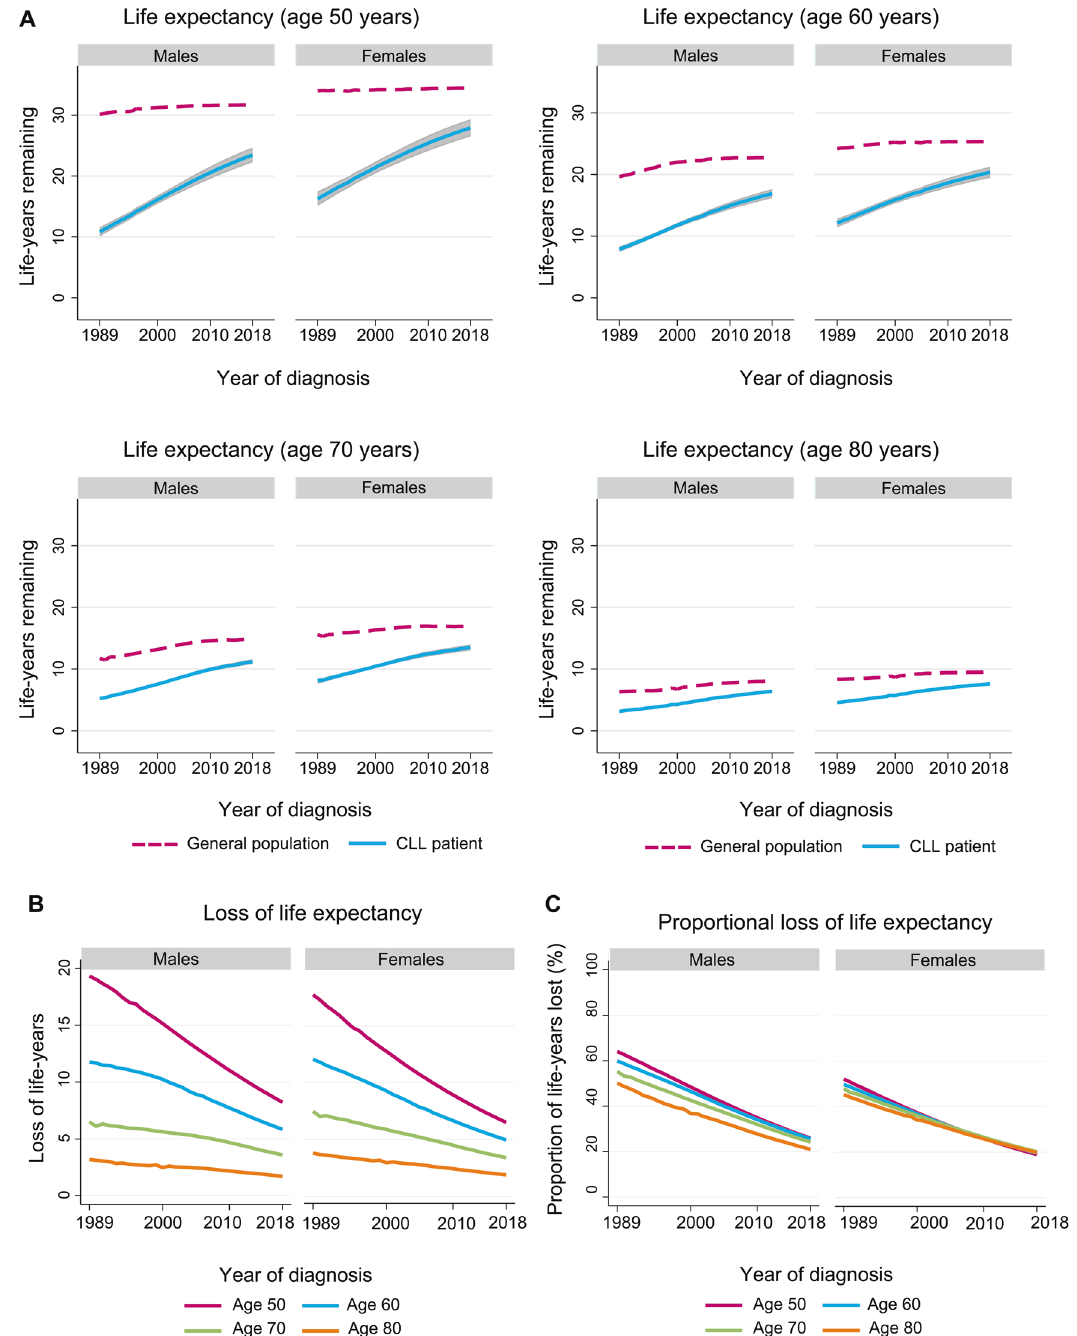
Fig. 1 Trends in various life expectancy measures of patients with chronic lymphocytic leukemia diagnosed in the Netherlands between 1989 and 2018. Panel A depicts the life expectancy of the general population (dashed lines) and patients with chronic lymphocytic leukemia (solid lines) by year of diagnosis for four age categories, strati fi ed by sex. The shaded area around the life expectancy of patients with chronic lymphocytic leukemia portrays the 95% con fi dence interval for the point estimates, which was obtained using the Delta method. Panel B presents the loss in expectation of life (LEL) of patients with chronic lymphocytic leukemia by year of diagnosis for four ages, strati fi ed by sex. Panel C presents the proportional loss in expectation of life (PLEL) of patients with chronic lymphocytic leukemia by year of diagnosis for four ages, strati fi ed by sex. The projected measures of life expectancy according to selected years of diagnosis are presented in Supplementary Table 2. Abbreviation: CLL, chronic lymphocytic diagnosed in 1990, there was a substantial decrease in the CLEL both sexes across all studied age groups in 2018, indicating excess with additional years survived post-diagnosis. In more recent mortality akin to fi ndings from the LEL (Fig. 1C and Table S2). years, the slope of the CLEL became less steep since the LEL in Overall, the CLEL decreased with each additional year survived these years is already comparatively low. Nevertheless, CLL post-diagnosis, irrespective of age and sex (Fig. 2). For patients